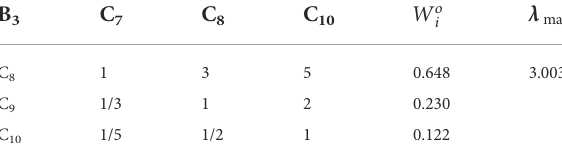
TABLE 6 Weights of second-tier indicators